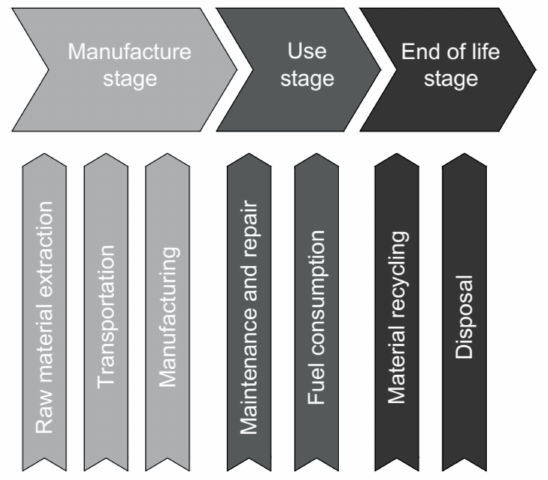
Figure 2. LCA system boundary definition applied to transportation